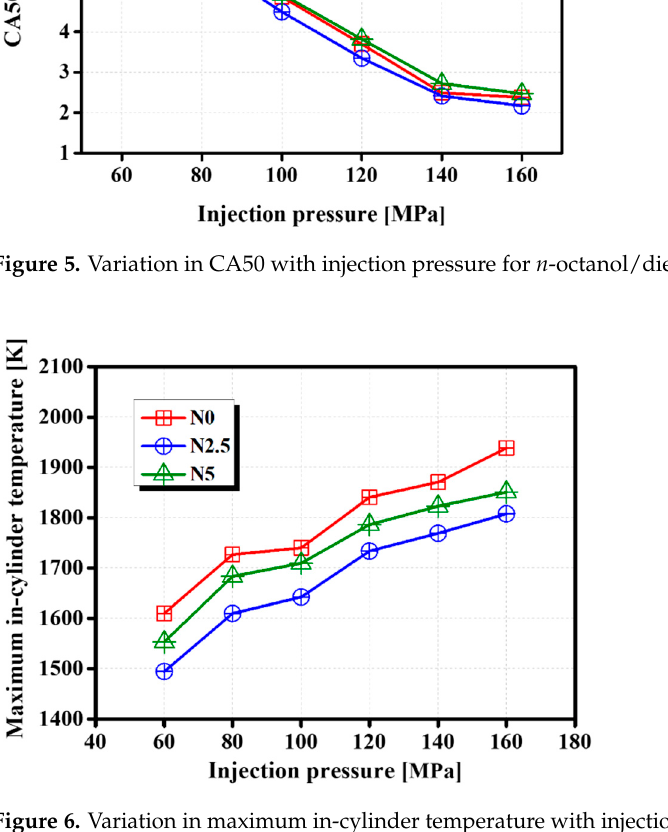
Figure 7. Curve analysis of brake specific fuel consumption according to injection pressure for n - octanol/diesel blends.